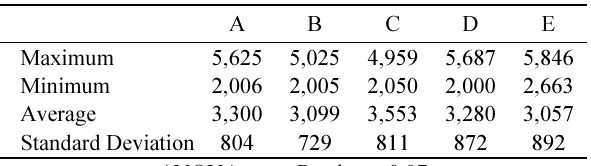
Table 3. ANOVA tests for maintenance and construction offic- es’ road repairing project contracts, unit: NT$/Tone/ Asphalt A B C D